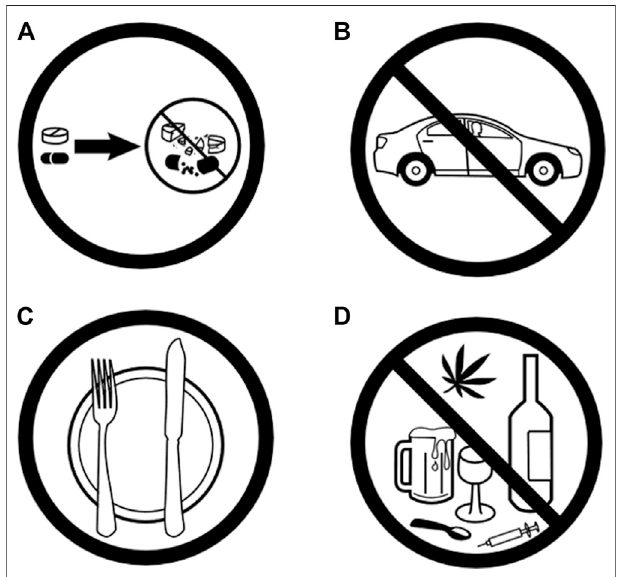
FIGURE 1 | Sample examples of pictograms used in pharmaceutical care: (A) Do not crush; (B) Do not drive; (C) Take with food; (D) Do not take with alcohol or drugs. Source: https://www. fi pfoundation.org/.